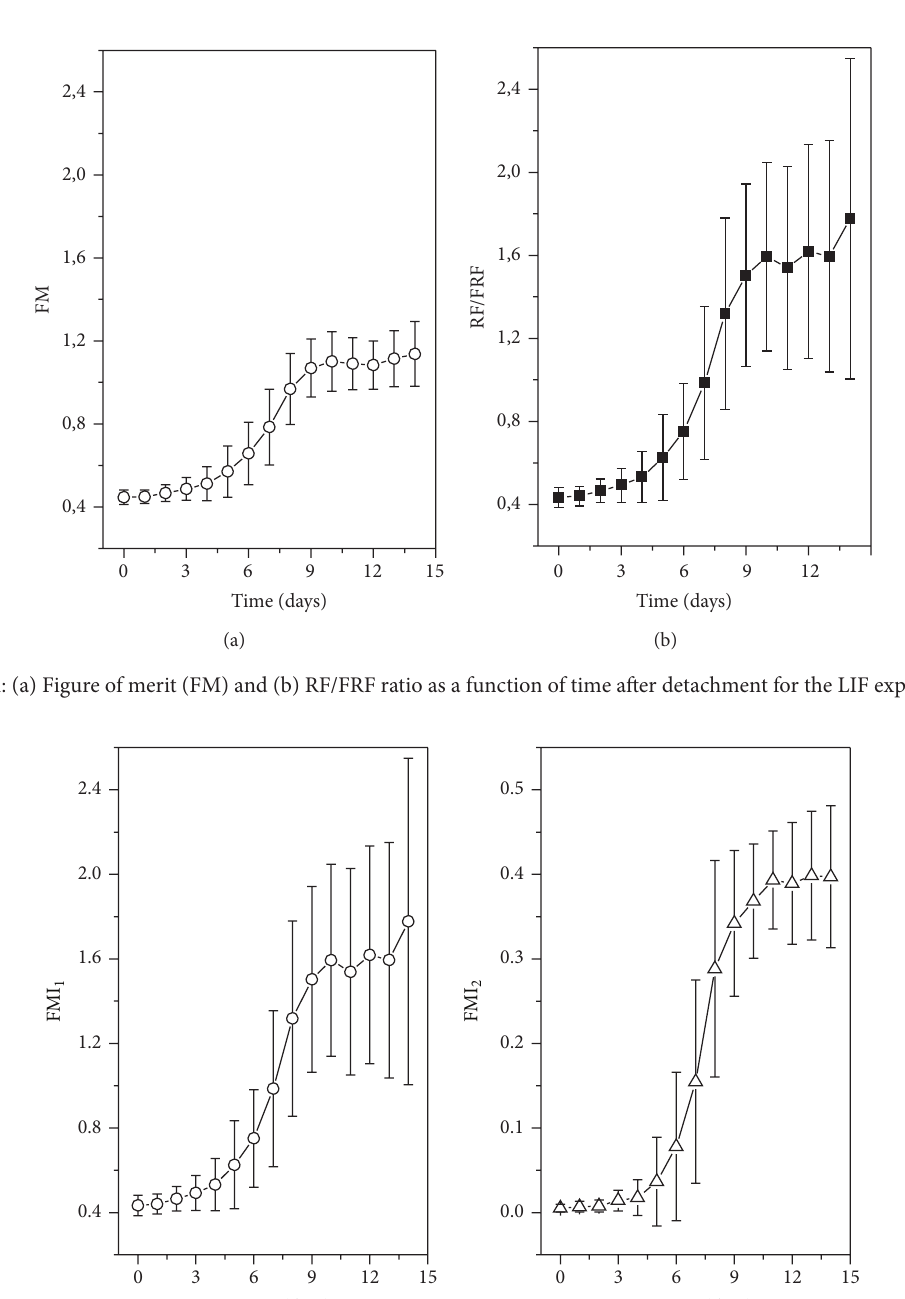
RF/FRF in the last six days of evaluation. As pointed